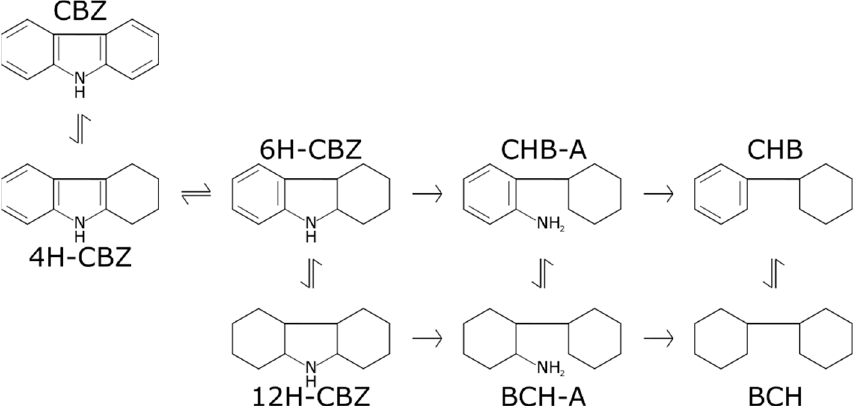
Figure 7. HDN network for carbazole (CBZ) to its HDN products: tetrahydrocarbazole (4H-CBZ), hexahydrocarbazole (6H-CBZ), dodecahydrocarbazole (12H-CBZ), cyclohexylbenzeneamine (CHB-A), bicyclohexylamine (BCH-A), cyclohexylbenzene (CHB), and bicyclohexane (BCH). Based on